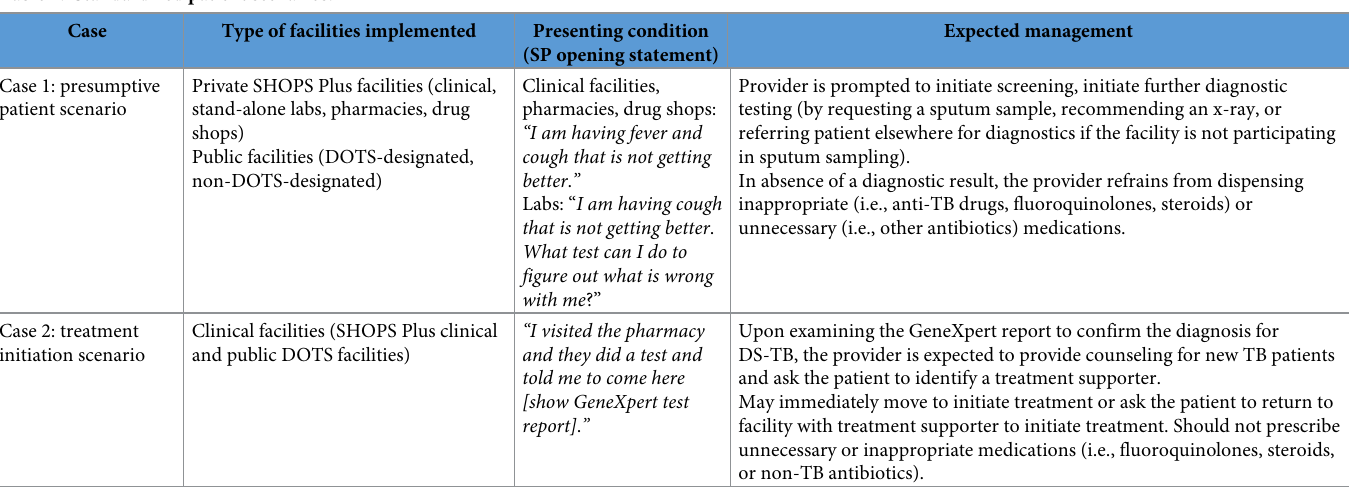
Table 1. Standardized patient